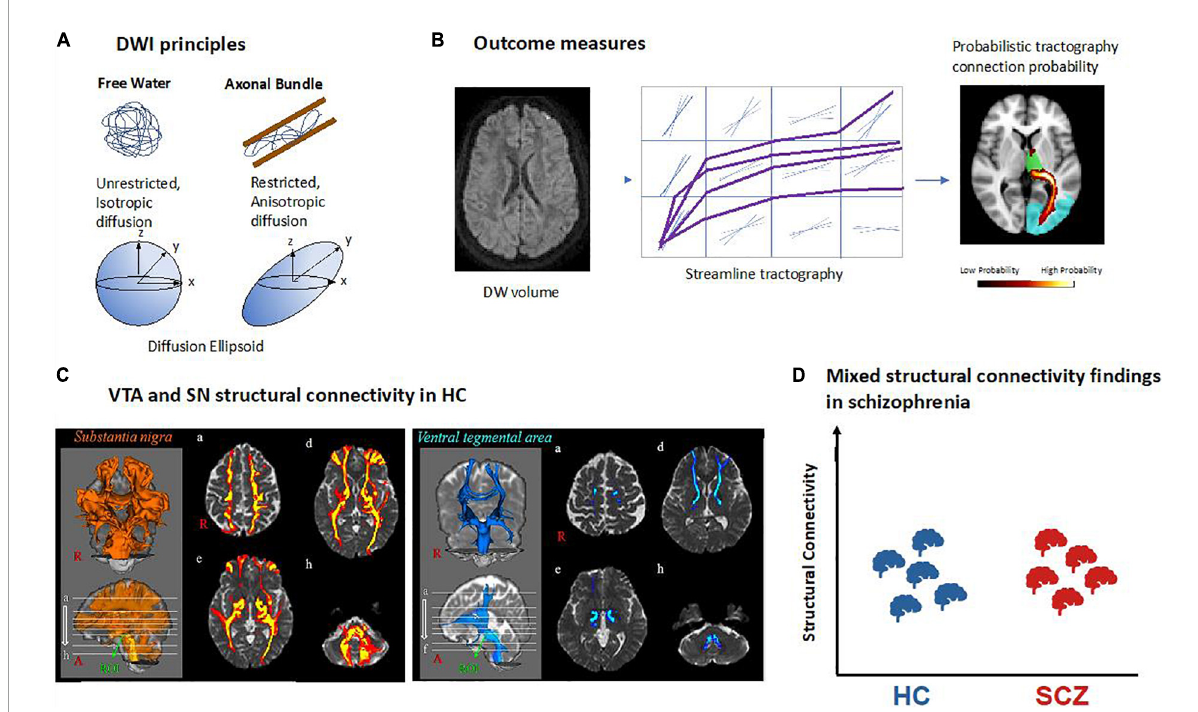
FIGURE4 Structural connectivity of dopaminergic nuclei in schizophrenia based on diffusion-weighted MRI. (A) Principles of diffusion-weighted imaging (DWI). Water molecules are free to diffuse in all directions in free water while their diffusion is restricted in biological tissue such as axonal fiber bundles and will follow their main orientation. It can be quantified using a mathematical model called a tensor which can be represented as an ellipsoid with its main axis representing the principal direction of diffusion. In the case of free water there is no principal direction of diffusion thus the ellipsoid takes the shape of a sphere. (B) Structural connectivity outcome measures. Example of a DWI volume. All DWI volumes are used to perform tractography between two regions of interest. In deterministic tractography, each reconstructed streamline follows the main direction of diffusion per voxel or while in probabilistic tractography as represented here, a distribution of possible orientations is modeled and each streamline is reconstructed from each possible orientation. In the reconstructed path, the value in each voxel represents how many streamlines passed through it. The higher number of streamlines per voxel, the higher the probability for that voxel to be part of a fiber bundle. (C) VTA and SN structural connectivity in healthy controls (HC). Example of probabilistic tractography from VTA and SN showing their connectivity to the rest of the brain [adapted with permission from (107)]. (D) Mixed structural connectivity findings in schizophrenia. Structural connectivity can be estimated by a variety of different outcome measures, making comparisons across studies difficult; so far, no clear trends have